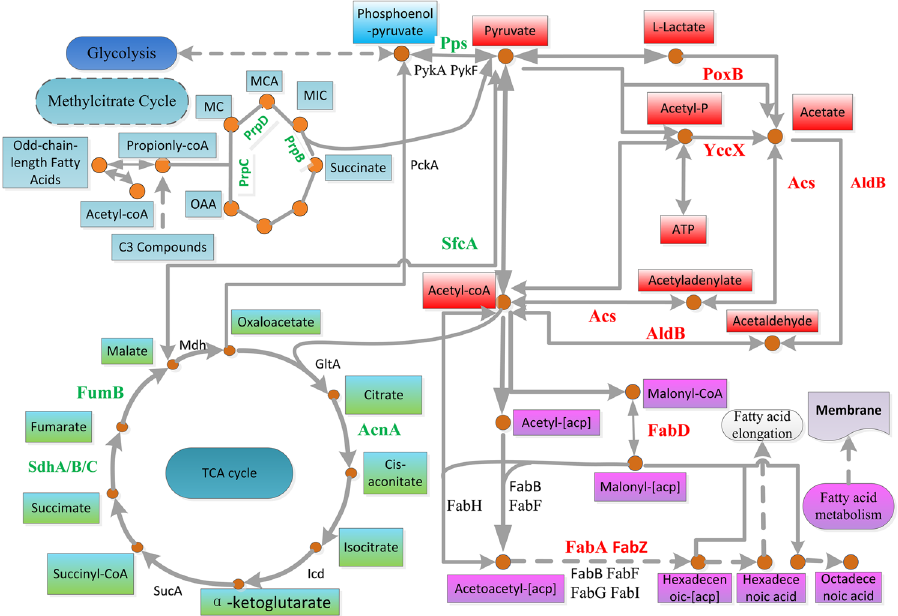
Figure 3. Metabolic pathways potentially associated with Mn oxidation and the Mn(II) stress response. The pathway included pyruvate metabolism, fatty acid metabolism and synthesis, the TCA cycle and glycolysis. The generally up- and down-regulated enzymes are represented in red and green,